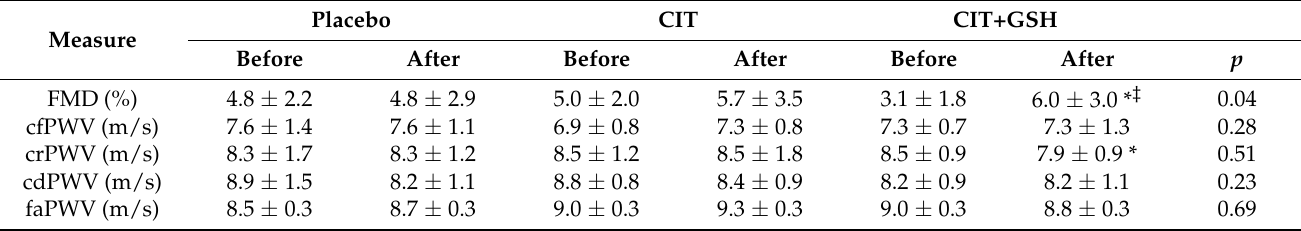
Table 2. Brachial artery endothelial function and arterial stiffness.